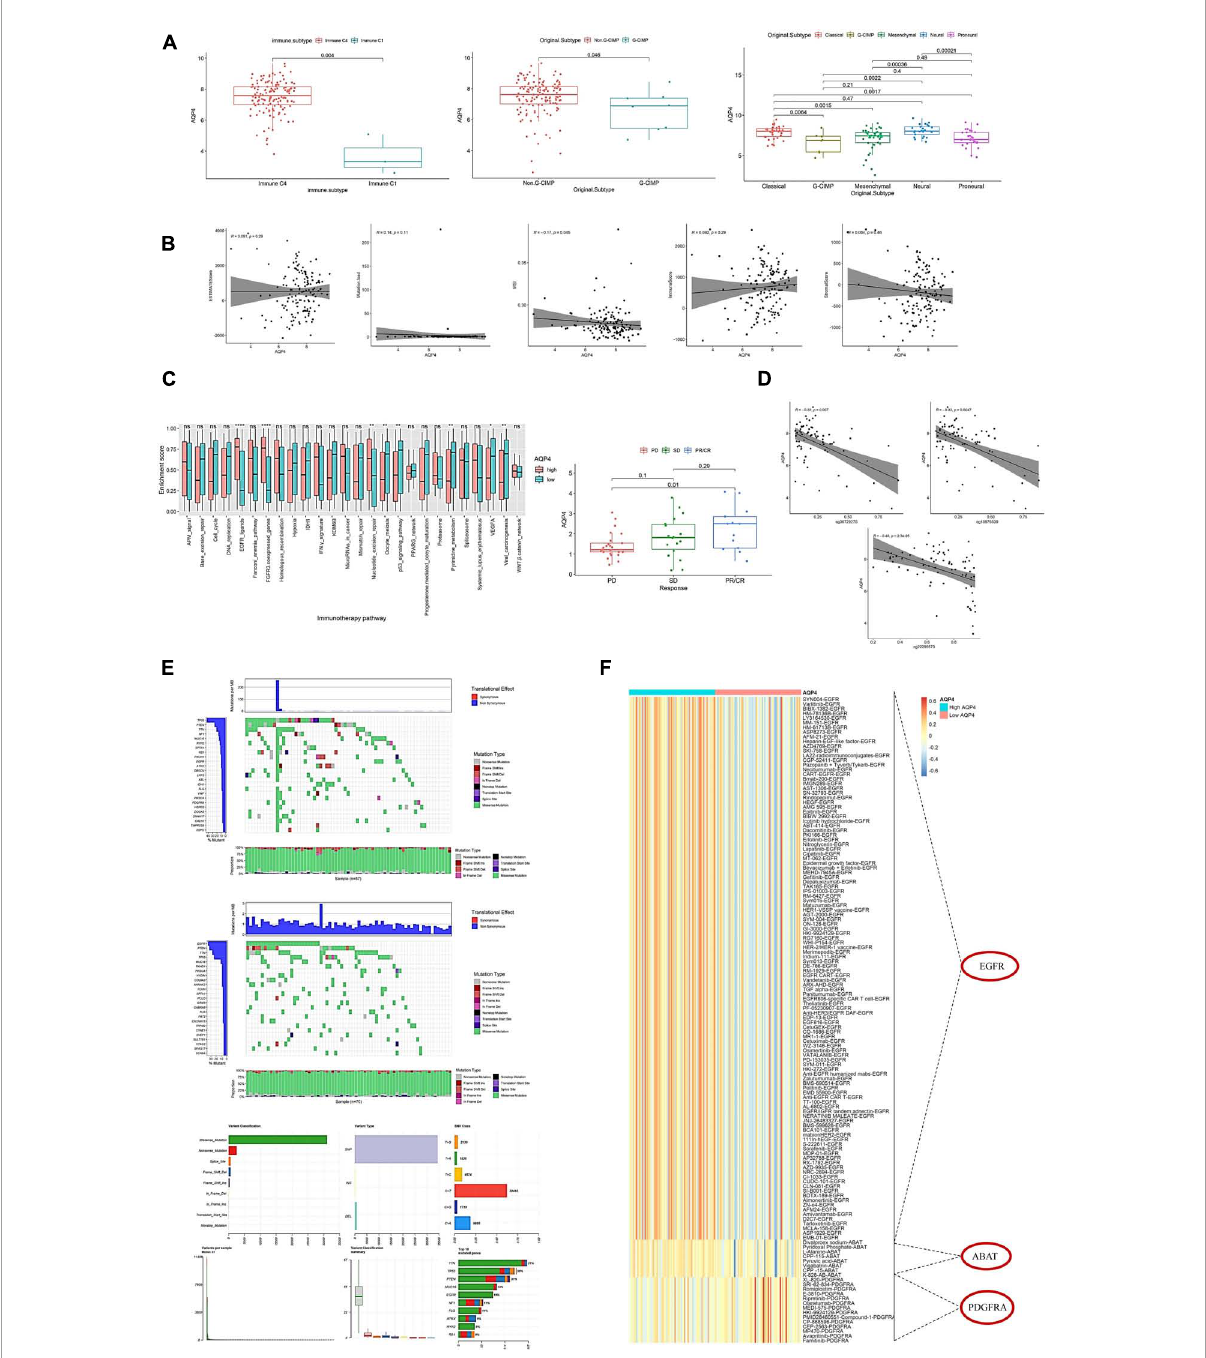
FIGURE5 Effects of AQP4 expression levels on clinical tumor characteristics and immunotherapy targets. (A) Differential expression of AQP4 gene in clinical features. (B) Correlation of AQP4 gene expression with tumor mutational burden (TMB), immune score, MSI, stromal score, and tumor purity. (C) Differential analysis of pathway enrichment scores for immunotherapy prediction. The left figure shows the difference in the enrichment scores of immunotherapy prediction pathways between the high and low expression groups of the AQP4 gene, and the right figure shows the difference analysis of different immune groups in the GSE91061 dataset. (D) Methylation and expression correlation analysis. (E) AQP4 gene expression high and low grouped mutation display. The upper figure is the AQP4 low expression group, the middle figure is the AQP4 high expression group, and the lower figure is the summary of the maf file. (F) Screening for differential expression of cancer-type therapeutic targets. * p < 0.05, ** p < 0.01, **** p <